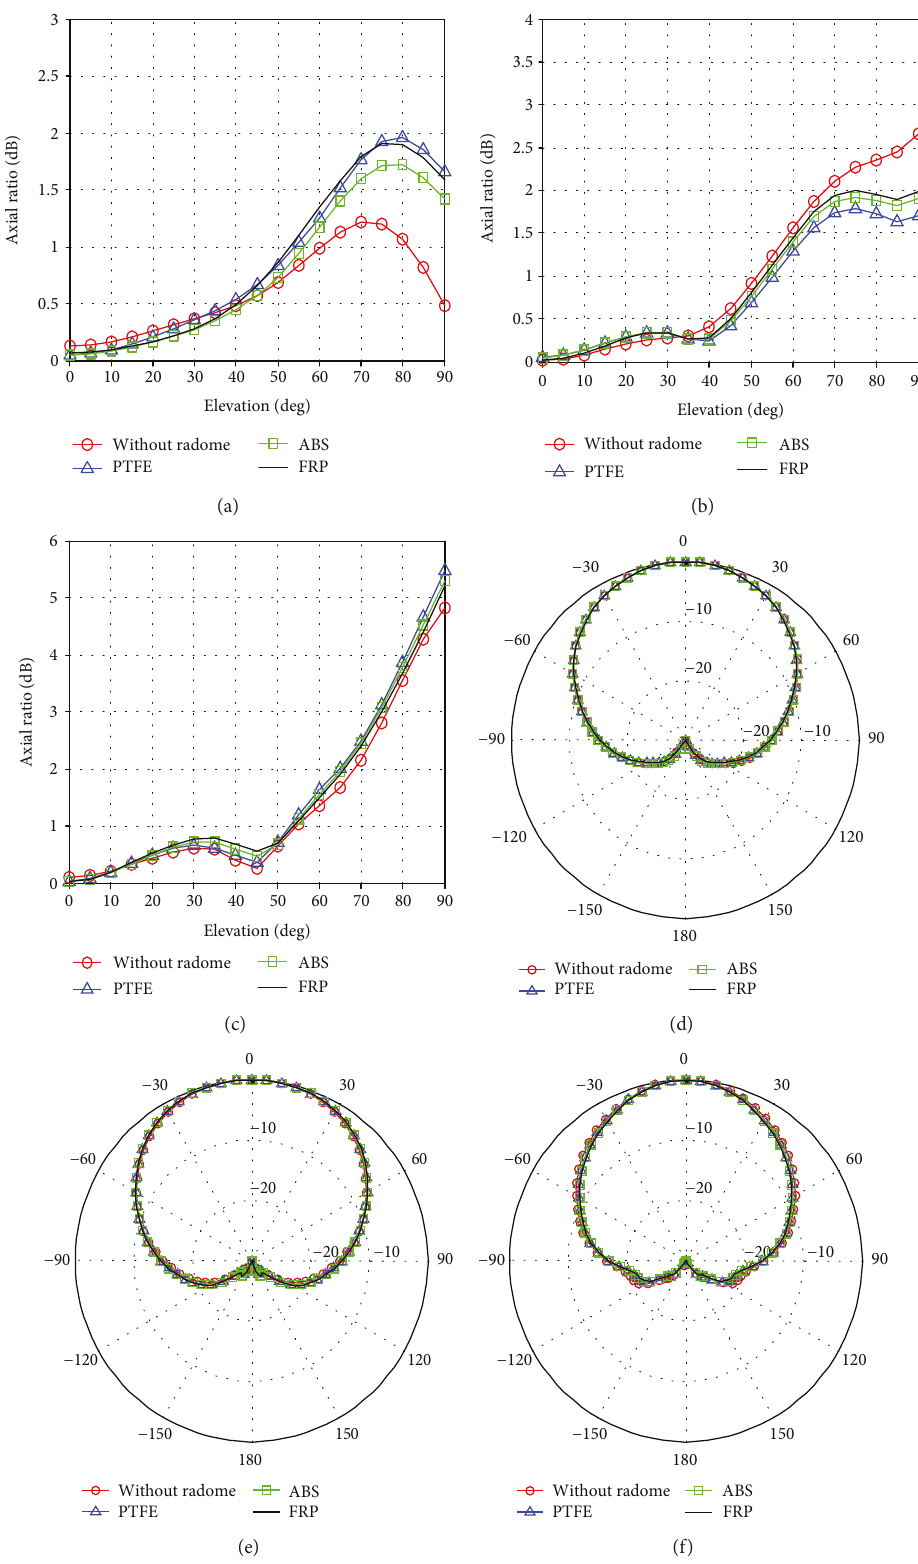
Figure 2: Simulated radiation characteristic comparison of antenna with di ff erent materials of radome: maximum axial ratio versus the elevation angle (a) at 1.22 GHz, (b) at 1.58GHz, and (c) at 2.5GHz; E-plane radiation pattern (co-pol) (d) at 1.22GHz, (e) at 1.58GHz, and (f) at